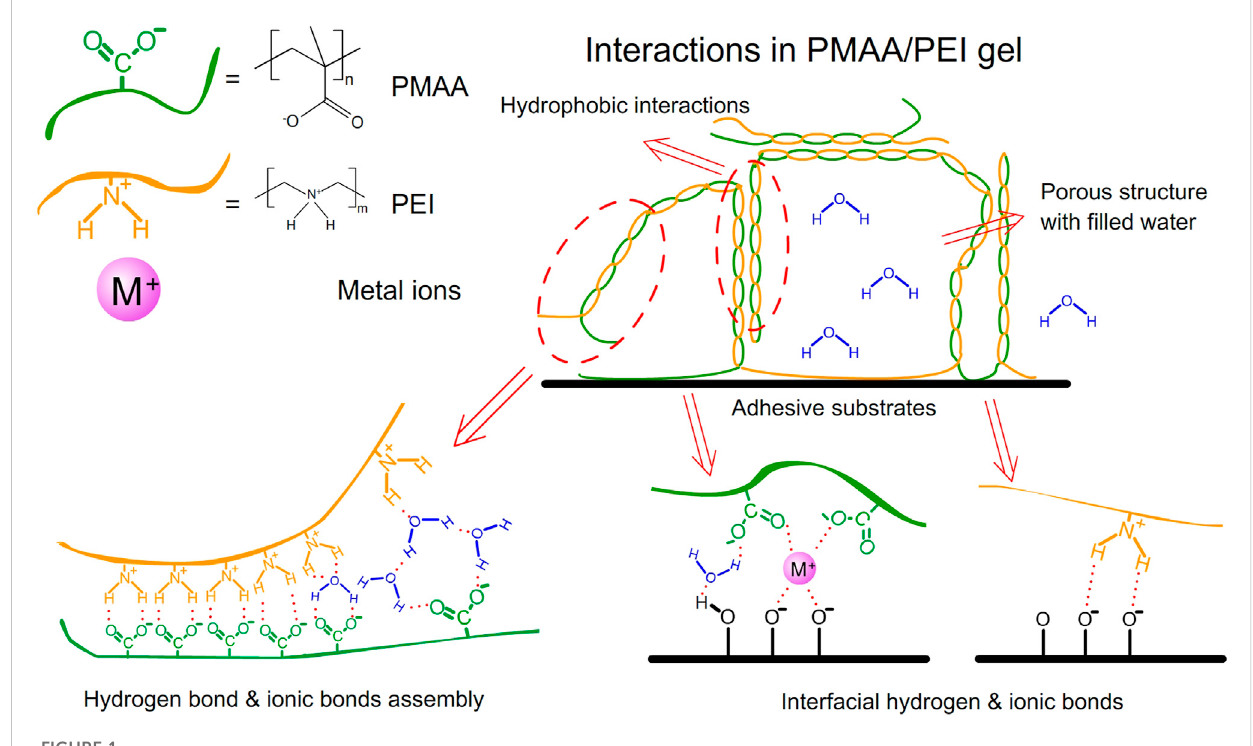
FIGURE 1 Interactions in PMAA/PEI